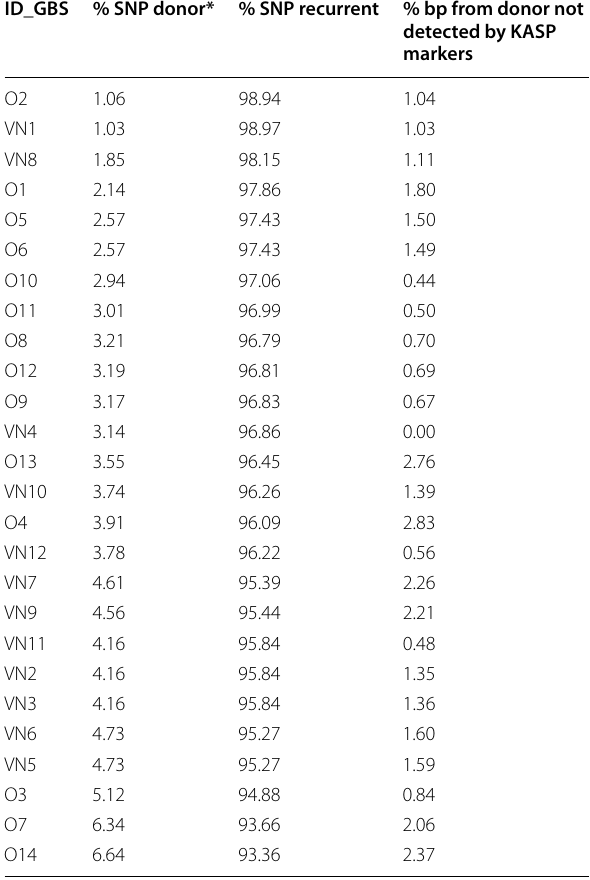
Table 3 Ranking of BC by the GBS results (% SNP donor) and comparison with performances of the 96 KASP markers